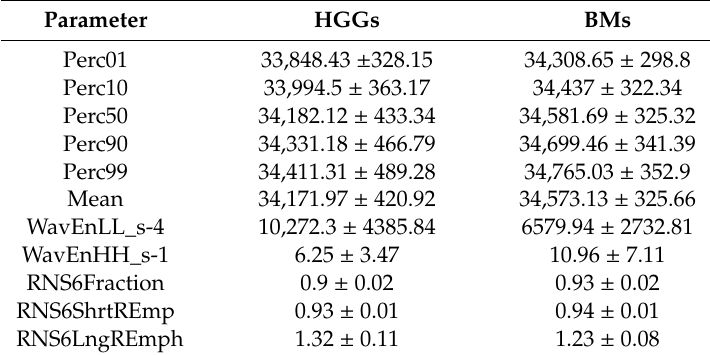
Table 2. The parameters that show statistically significant results at the univariate analysis and their average values recorded in each group. Parameter HGGs BMs Perc01 33,848.43 ±